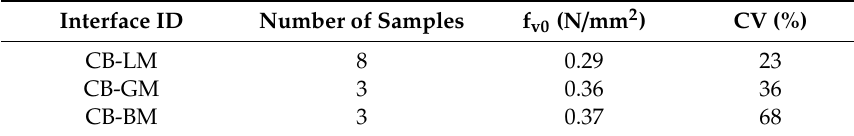
Table 6. Bond strength of mortar–brick and matrix–brick interfaces.